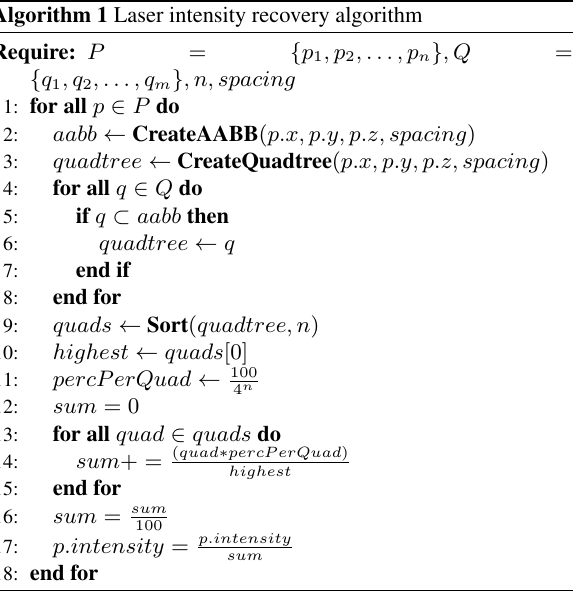
where perc is the total collision percentage for each quadtree quadrant and n is the quadtree level. Algorithm 1 Laser intensity recovery algorithm